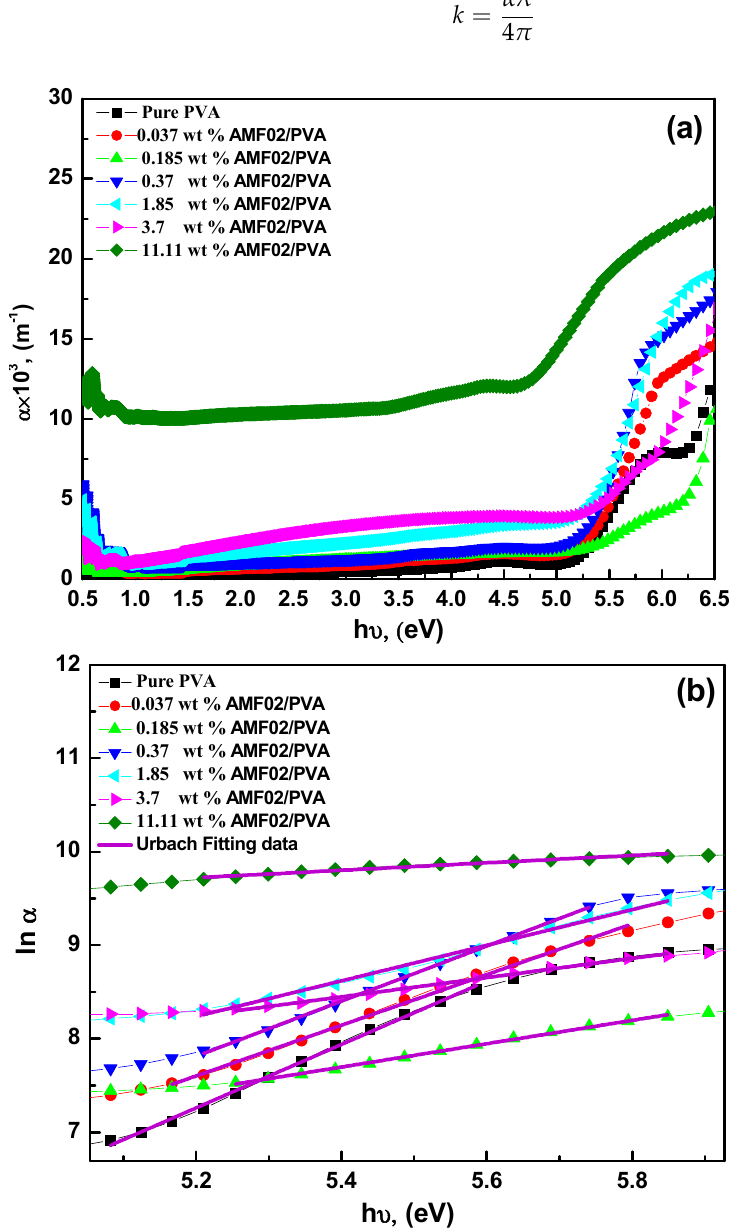
Figure 5. ( a ) The absorption coefficient variations vs. photon energy ( h υ ), and ( b ) the Urbach energy plot ( ln α vs. incident photon energy ( h υ )) for AMF02/PVA novel PCCEFs.